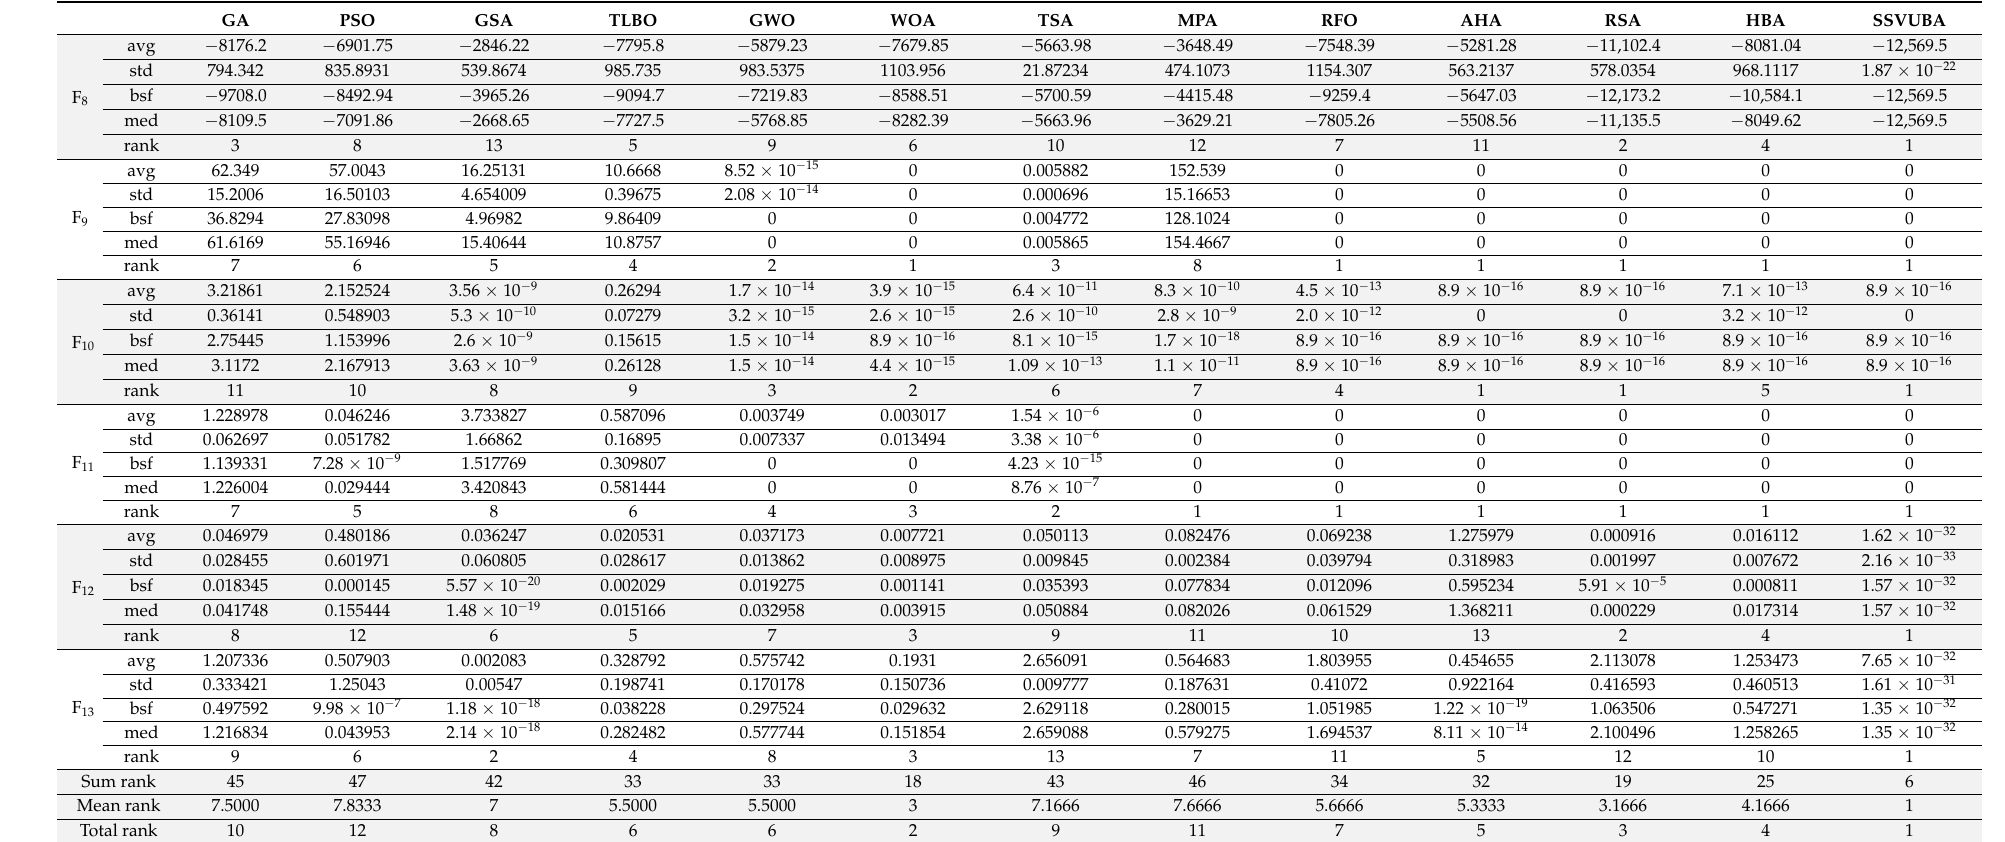
Table 3. Assessment results of high-dimensional multimodal